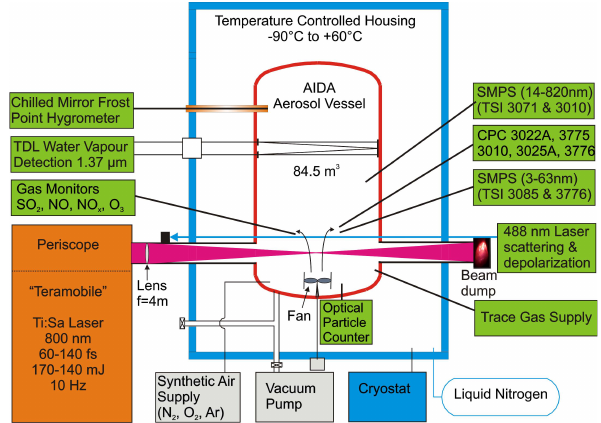
Fig. 1. Schematic of the experimental set-up of the Teramobile laser system at the AIDA aerosol and cloud chamber. The terawatt laser beam (red line) is generated in a container outside the AIDA hall and directed via transfer optics, a focussing lens (f = 4m), and an entrance window (139mm diameter, 9.8mm thickness) across the AIDA vessel and the air flux from its mixing fan. The beam exits at opposite side through an exit window into a beam dump. Sampling tubes for particles and trace gases are shown as black lines. The light blue line represents the 488nm laser beam used for in situ light scattering